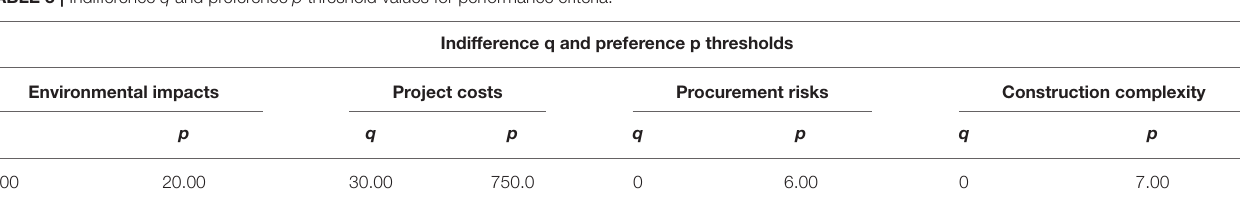
TABLE 3 | Indifference q and preference p threshold values for performance